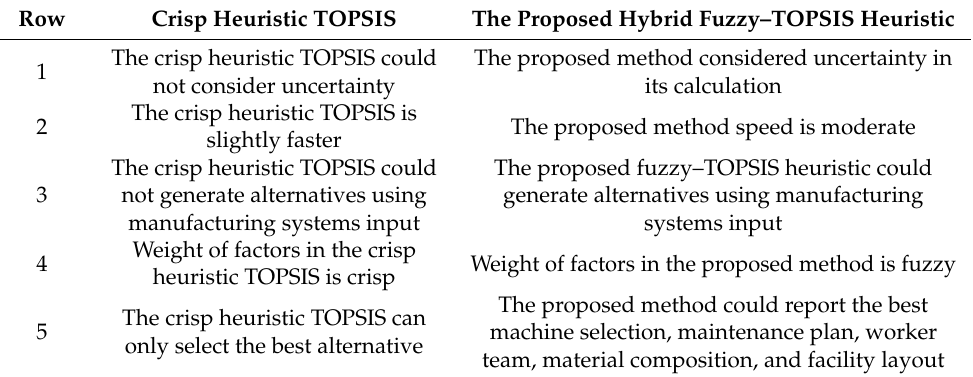
Table 13. Results of comparing the crisp heuristic TOPSIS with the proposed fuzzy–TOPSIS heuris- tic.